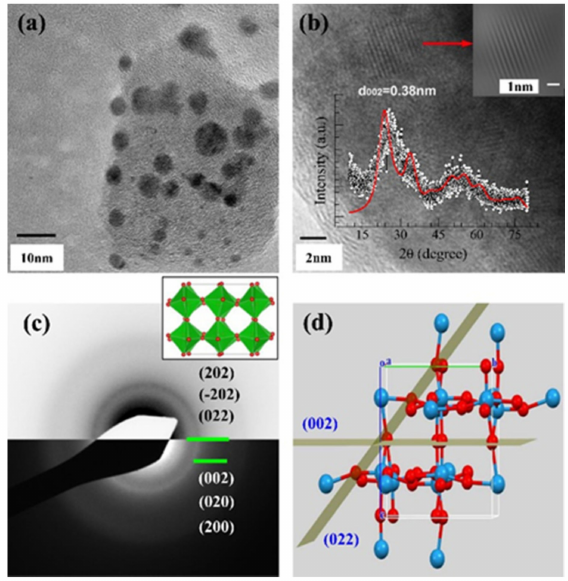
Figure 5. ( a ) TEM and ( b ) HR-TEM images with 10 and 2 nm scale bars, respectively. The inset shows the X-ray nature of the synthesized film. The SAED pattern of the corresponding film is shown in ( c ), and the inset shows that the monoclinic WO 3 phase is mostly composed of corner-linked octahedra of 4-membered channels along all crystallographic directions. The 002 and 022 crystallographic planes obtained from the SAED patterns are projected in ( d ). All crystallographic projections were made with the VESTA structure drawing software